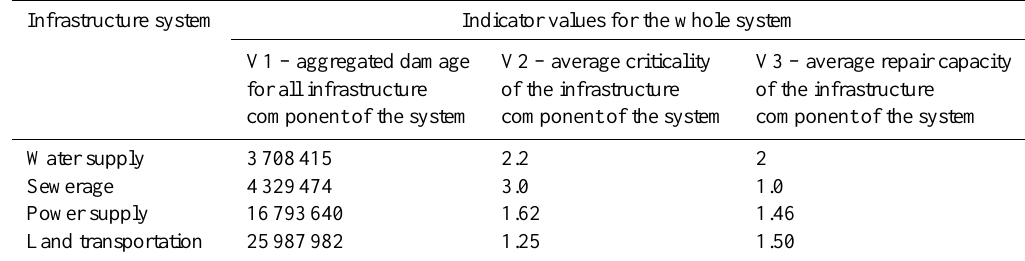
Table 6. Vulnerability matrix for the 4-infrastructure system considered in this study.